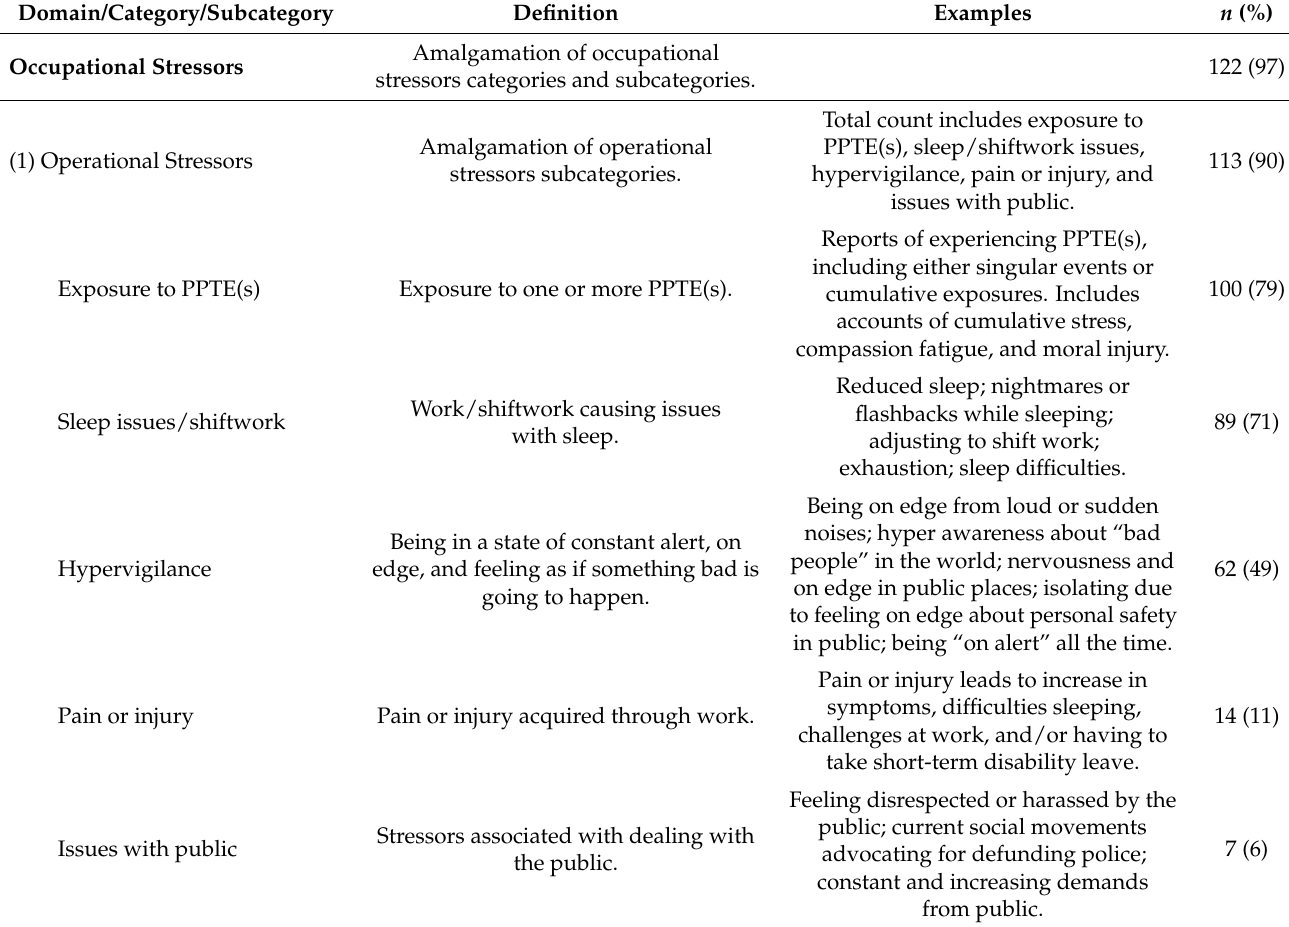
Table 3. Reasons for seeking ICBT, including occupation and personal stressors, reported during screening ( N =